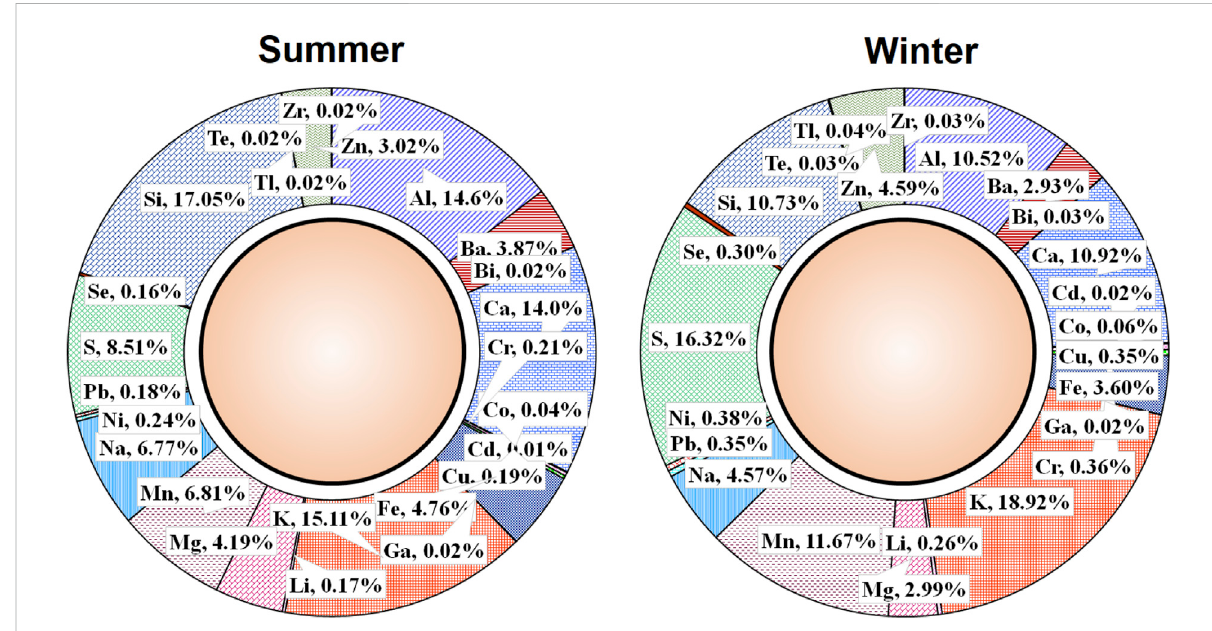
FIGURE 4 Percentage compositions of individual elements in total elemental concentration (sum of all measured elements) during summer and